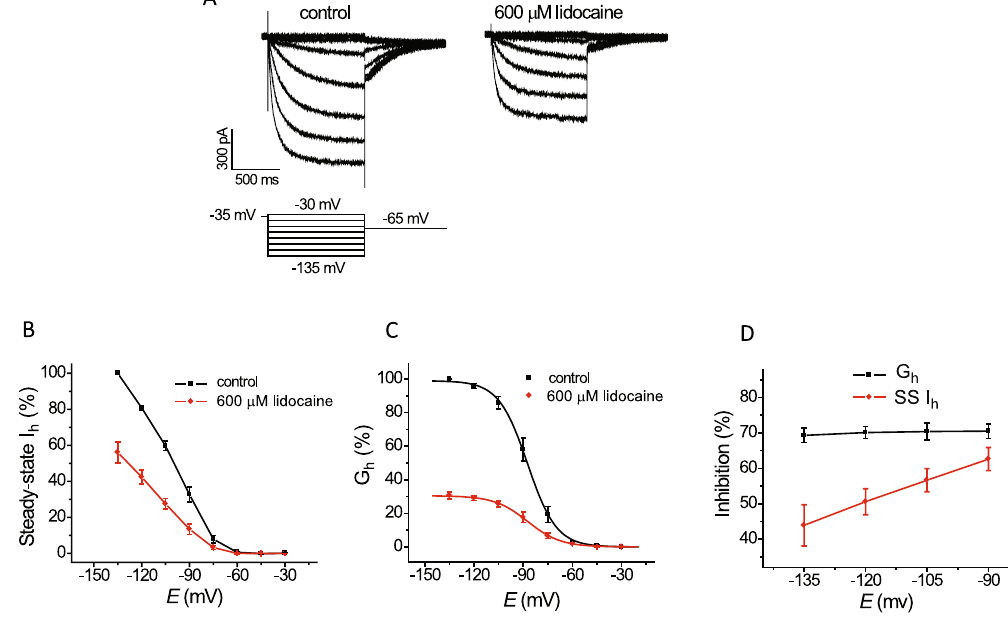
Figure 1. Lidocaine inhibits HCN1-mediated I h conductance to a greater extent at less negative voltages but does not alter the voltage-dependence of I h activation. ( A ) Representative traces of I h activated by membrane voltages in the range from − 30 mV to − 135 mV at 30 mM extracellular potassium under control conditions and following application of 600 µ M lidocaine. Activation voltage pulses were followed by a repolarization to − 65 mV. ( B ) Plots of steady-state I h , before and after lidocaine, versus voltage, collected from current traces as shown in ‘ A ’; I h amplitudes in the presence of lidocaine were normalized to those in the control solution lacking lidocaine. ( C ) Plots of G h , determined from tail current amplitudes at − 65 mV as shown in ‘ A ’, before and after lidocaine, versus voltage; I h amplitudes in the presence of lidocaine were normalized to those in the control solution lacking lidocaine. The solid curved line represents fitting of the values by a single exponential Boltzmann relation. Neither the mid-activation voltage ( V 1/2 ) of G h nor the slope factor of this relationship was altered (n = 4; − 87.2 ± 2.7 vs. − 86.9 ± 3.6 mV and 8.5 ± 0.6 vs. 8.7 ± 0.6; paired t -test, P = 0.79 and P = 0.89, respectively). ( D ) Plots of the fraction of steady-state I h and G h inhibited by lidocaine versus voltage. Steady- state I h inhibition increased from 43.9 ± 5.8% at − 135 to 62.4 ± 3.3% at − 90 mV (n = 4; ANOVA, P = 0.038) whereas G h was not altered significantly (n = 4; 69.3 ± 2.0 versus 70.5 ± 2.1%; P =